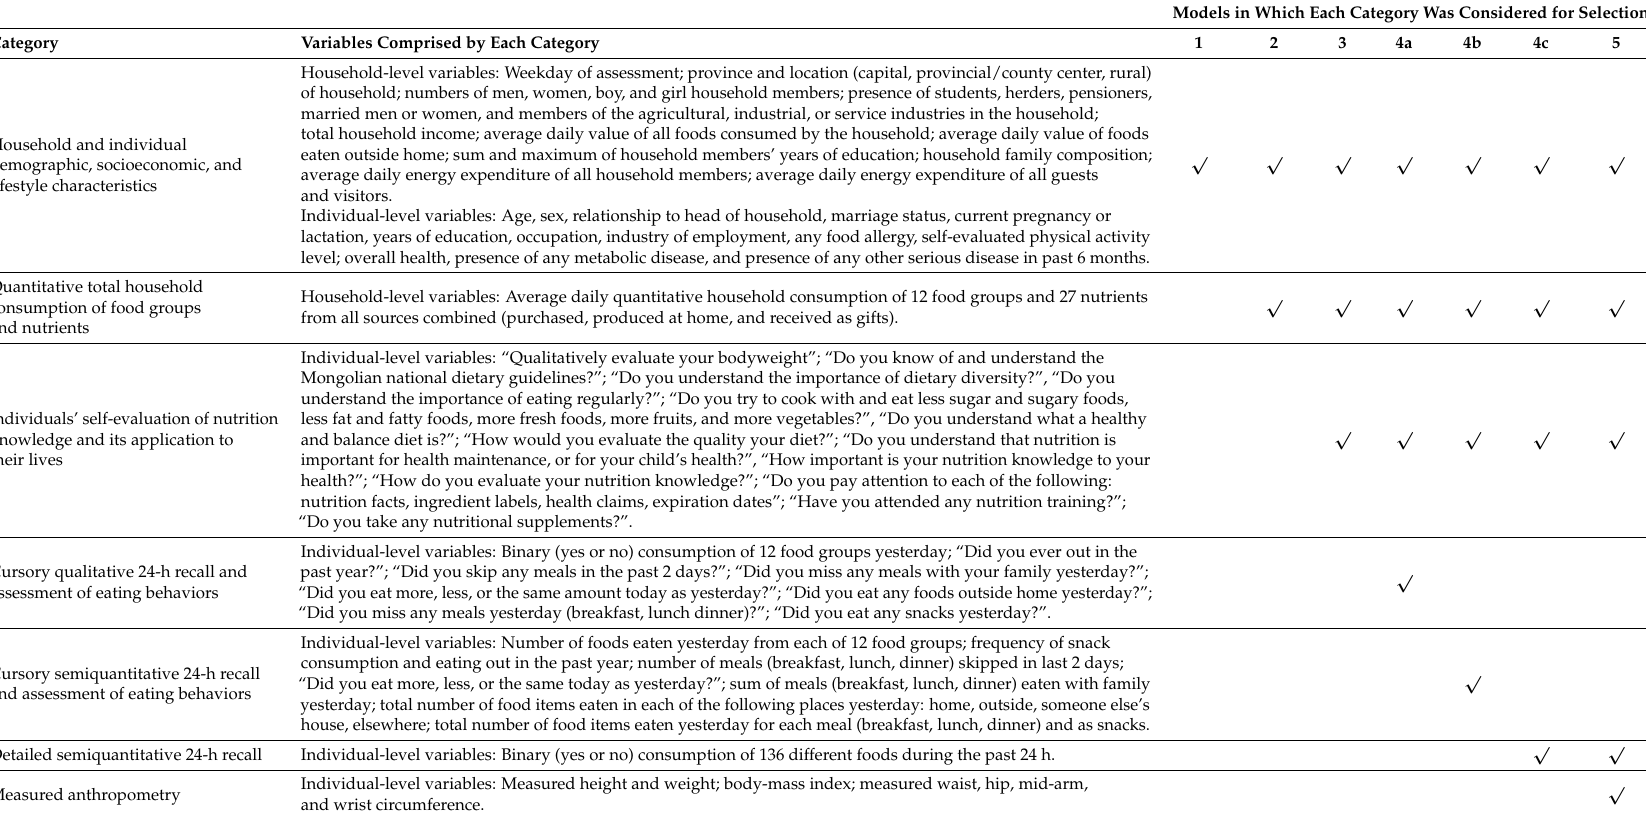
Table 4. Categories of household- and individual-level variables considered for selection in predictive models of individuals’ dietary nutrient intakes and intake densities in the FCS-24 (Aim